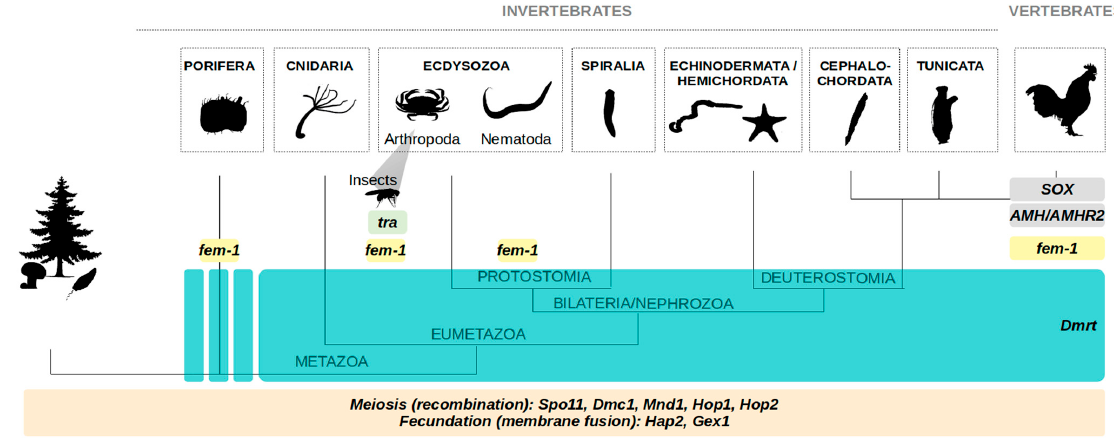
Figure 2. Conservation of key players of sexual reproduction and of the sexual differentiation pathways. Meiosis-specific genes (in beige) are present across most eukaryotic lineages: Spo11, Dmc1, Mnd1, Hop1 and Hop2 are involved in the recombination process. Hap2 and Gex1 (also in beige) are, respectively, involved in cell and nuclear fusion, and are also shared by most eukaryotes. Found throughout Eumetazoa (in blue-green), the Dmrt gene family is widely involved in the sex determination/differentiation cascade. It was also described in some other Metazoa from the Porifera phylum but its role has to be investigated (dashed blue-green square). The fem-1 ( feminizer ) gene is linked to the regulatory cascade of Dmrt in Nematoda and Arthropoda but it has also homologs—without defined function to date—in distant phyla such as Porifera or vertebrates (in yellow). More specifically, but ubiquitously in insects, tra ( transformer , in light green) has been described as the key regulator of Dmrt sex-specific splicing. Other conserved molecular players in vertebrates are SOX (SRY-related HMG-box), and AMH (anti-Müllerian hormone) and its receptor (AMHR2) as upstream and downstream effectors respectively (in grey).